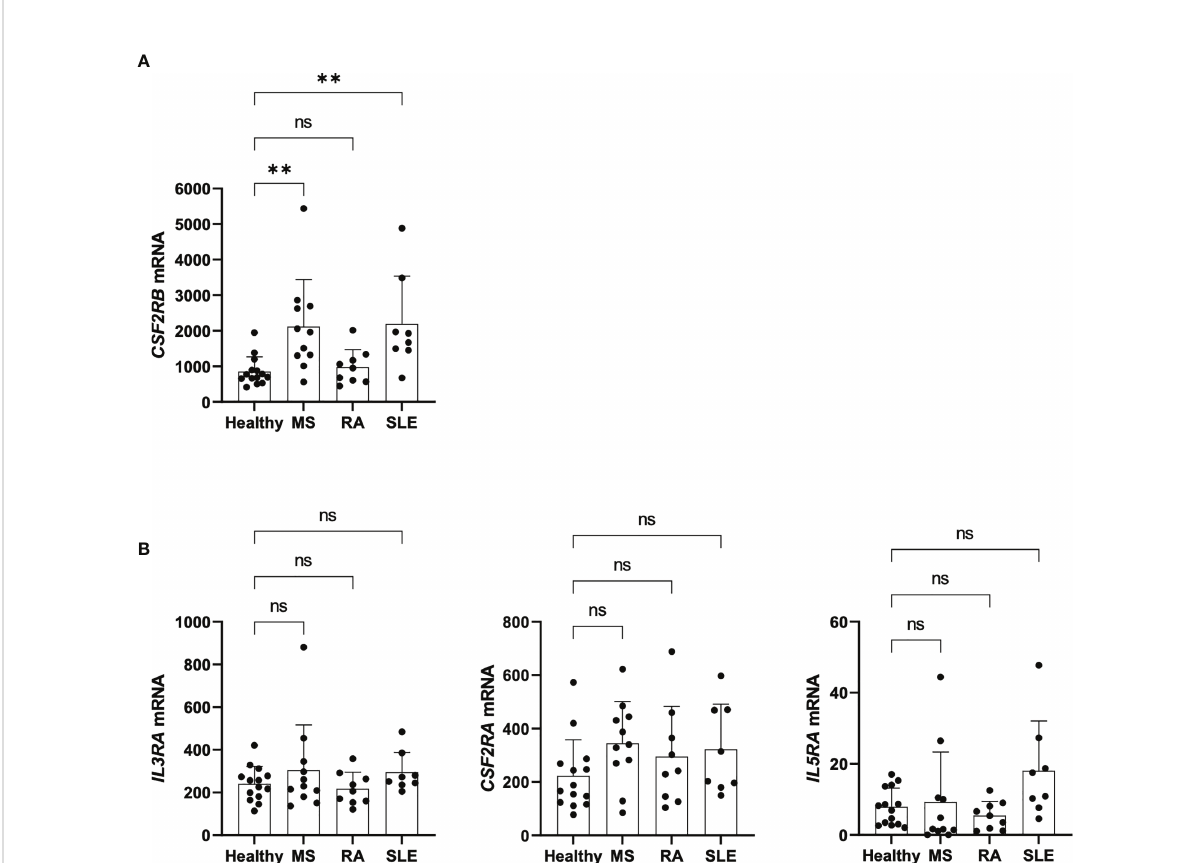
FIGURE 7 CSF2RB expression of Tregs in patients with autoimmunity. (A) CSF2RB mRNA levels in Tregs isolated from healthy individuals (n= 14), and patients with MS (n= 11), RA (n= 9) and SLE (n= 8). Data obtained and reanalyzed from (3). (B) IL3RA, CSF2RA and IL5RA mRNA levels in Tregs isolated from healthy individuals (n= 14), and patients with MS (n= 11), RA (n= 9) and SLE (n= 8). Data obtained and reanalyzed from (3). Mean ± SD is shown. Normal distribution was assessed by Shapiro-Wilk normality test with a signi fi cance level of 0.05. Signi fi cance was calculated by Kruskal-Wallis test with Dunn ’ s multiple comparisons test. ns for P > 0.05; ** for P ≤